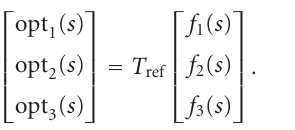
as well as three disturbances. Simulated through MATLAB and SIMULINK, these disturbances are three-band-limited white noises with mean 0 and standard deviation 2. Faults f 1 and f 2 are both simulated by a unit positive jump connected from the 14th second. Fault f 3 , simulated by a soft bias (slope = 0 . 2), is connected from the 20th second. Figure 2 gives the residual responses before the algorithm, where each residual is dedicated to a particular fault, while Figure 3 gives the op- timized residual response using our